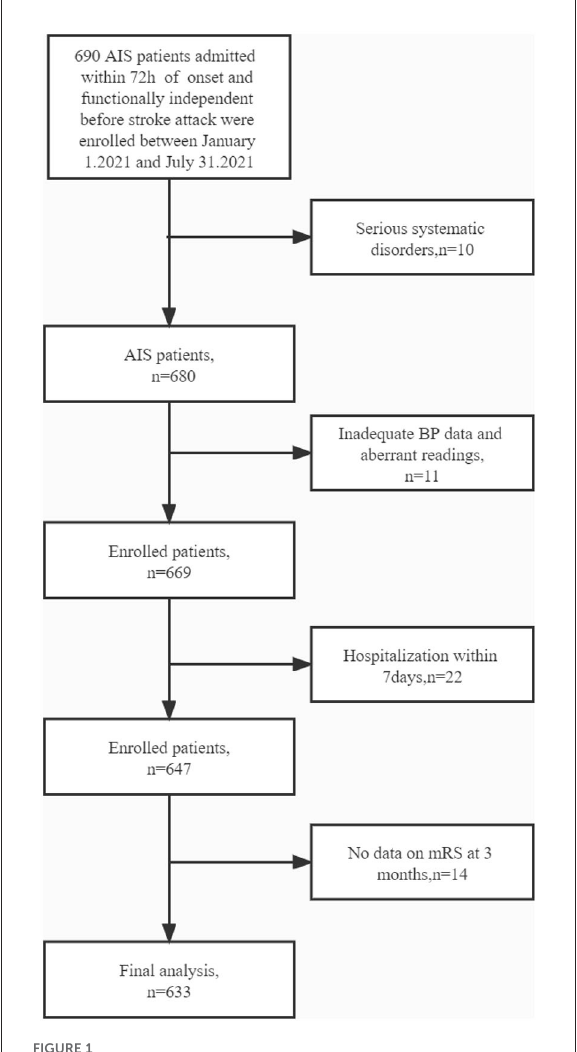
FIGURE1 Flowchart demonstrating patient